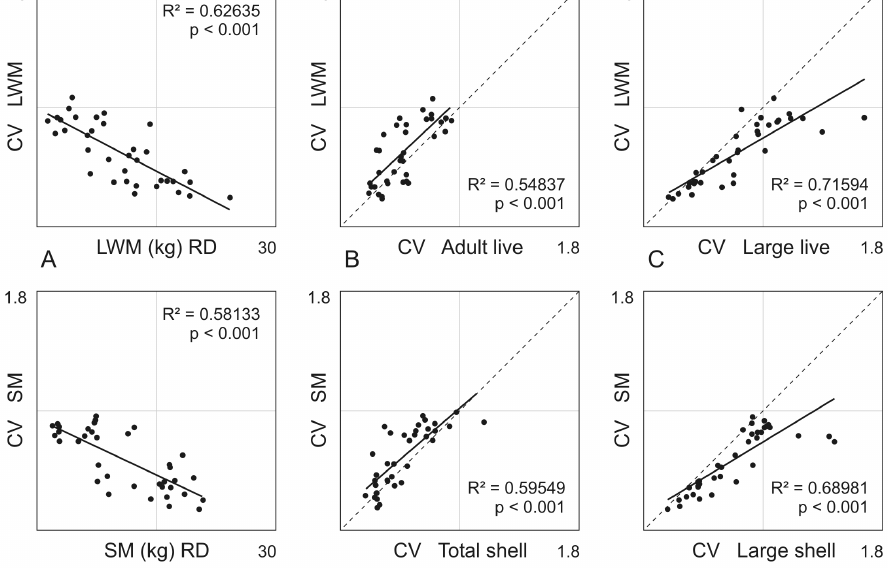
Figure 10. Coefficient of variation (CV) of selected oyster density attributes per site and year (N = 36 reefs). A Relationship between areal biomass and CV. B, C Interrelations between CV of abundance and areal biomass. Given are linear relationship, coefficient of determination (R²) and significance level (p). Proportional reference line indicated (dotted). See text for all other relationships. Density metrics and density attributes according to Figure